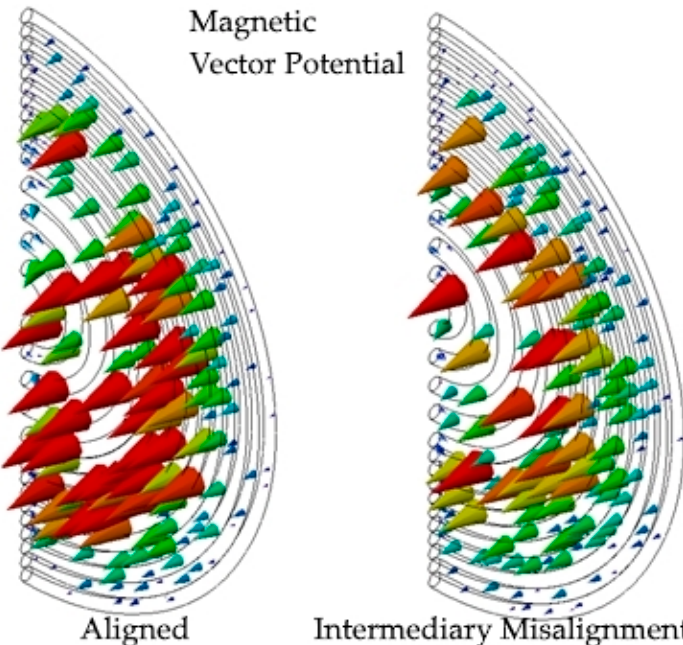
Figure 17. Magnified views of magnetic vector potential of hybrid intercore coil.